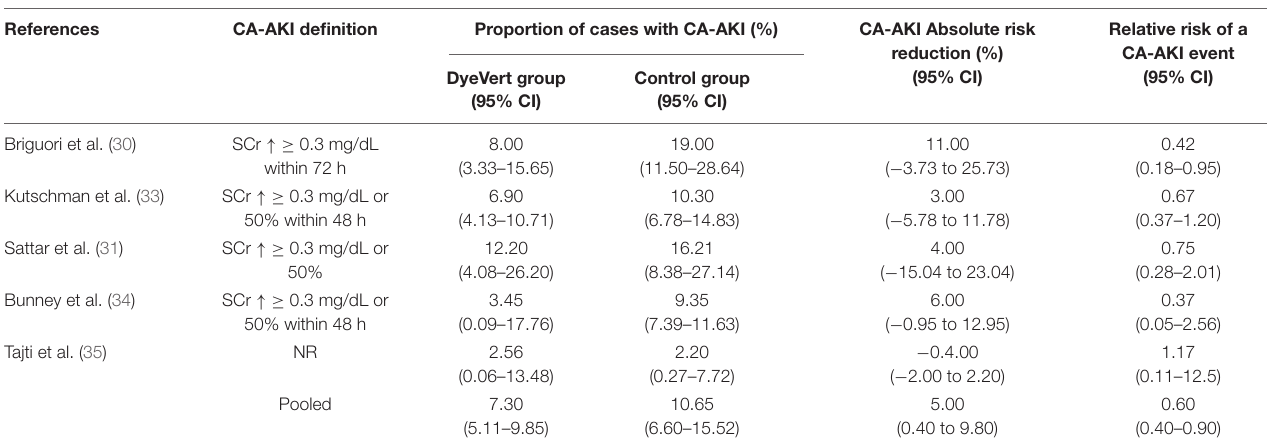
TABLE 5 | Contrast-associated acute kidney